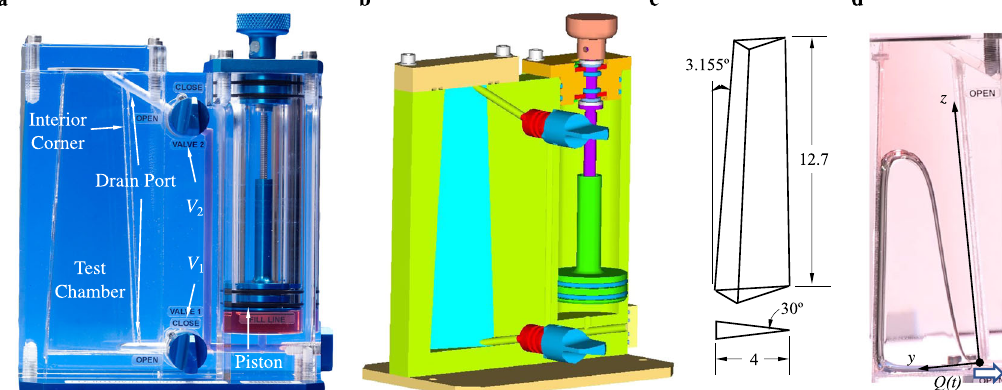
Fig. 1 Annotated ICF-1 test vessel. Slender truncated 75-30-75 isosceles triangle-based pyramid with 3.155 ∘ taper. a Camera view of apparatus with valves V 1 and V 2 labeled, b solid model, c tapered test chamber wire model with dimensions in cm, where large-end (bottom) to small-end (top) cross-sectional isosceles triangles are congruent through a 20:13 ratio, and d cropped image of test chamber single drain operation aboard ISS. In addition to a superposition of the relevant coordinate system, d provides a bold blue arrow indicating drain direction at fl ow rate Q ( t ).